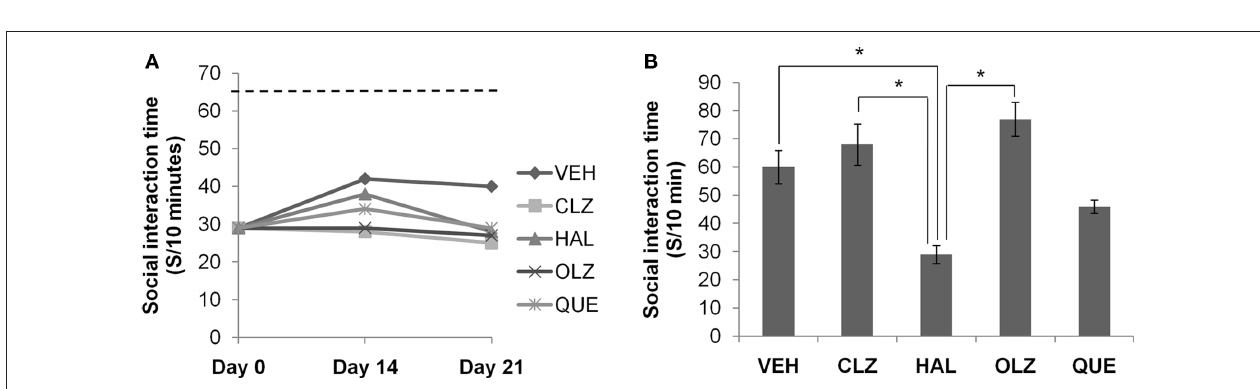
Figure 3 | Social interaction deficit did not recover after CPZ withdrawal. (A) The data from the recovery experiment, in which the dotted line indicates the value of the controls (CNT), which was significantly higher than all other groups. (B) The data from mice exposed to antipsychotics, but not to CPZ. Data are mean ± SEM ( n = 6/group). * p <